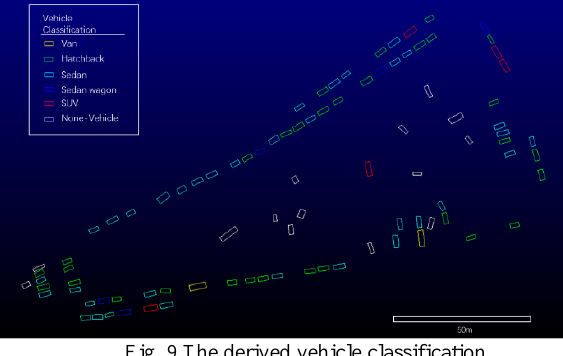
Fig. 9 The derived vehicle classification